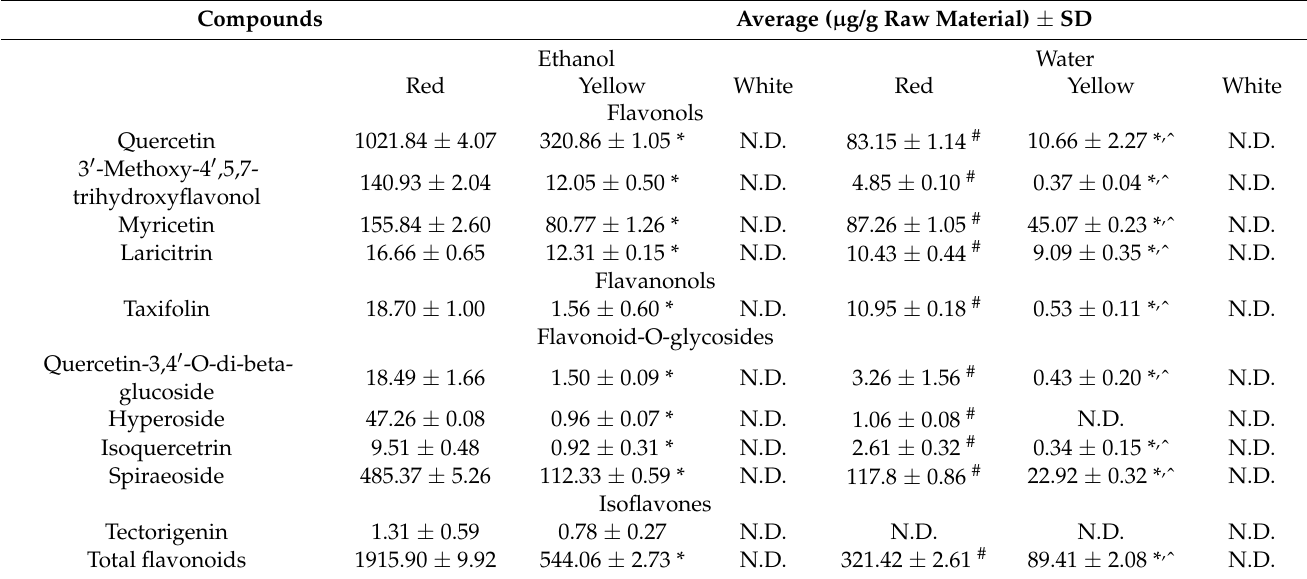
Table 1. Compounds in the ethanolic and aqueous extracts of onion